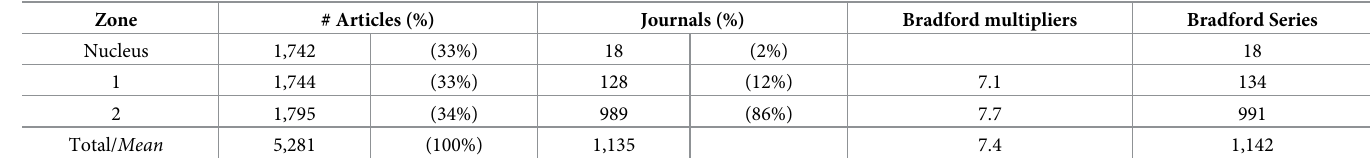
Table 3. Bradford zoning.